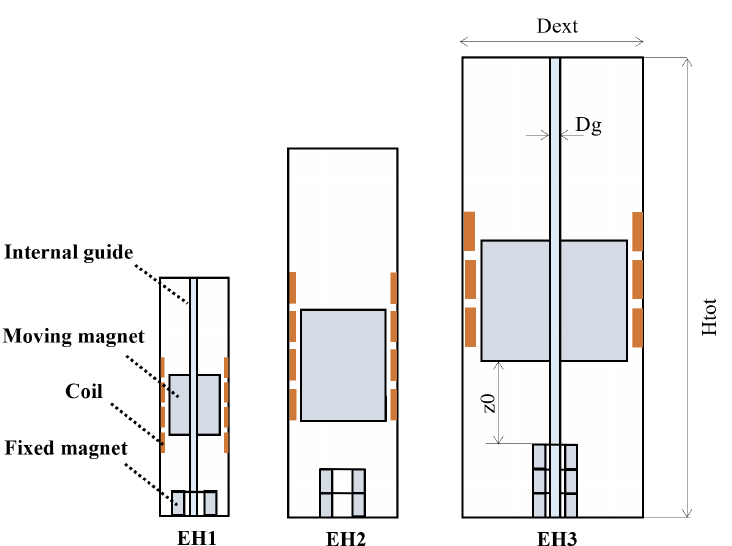
Figure 1. Schematic representation of the harvesters.